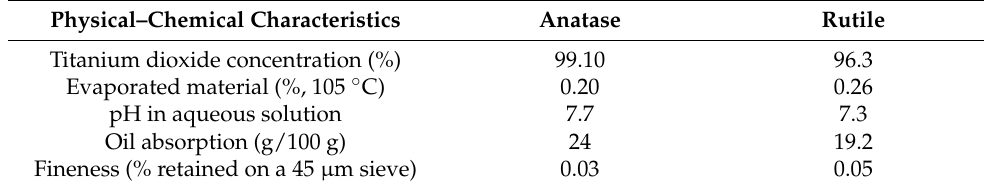
Table 2. Properties of the anatase and rutile titanium dioxide.